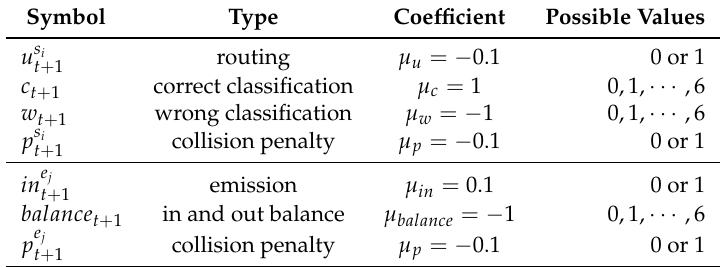
Table 1. The components of rewards at time step t + 1 caused by the actions performed by the routing agents and the emission agents at time step t . Symbol Type